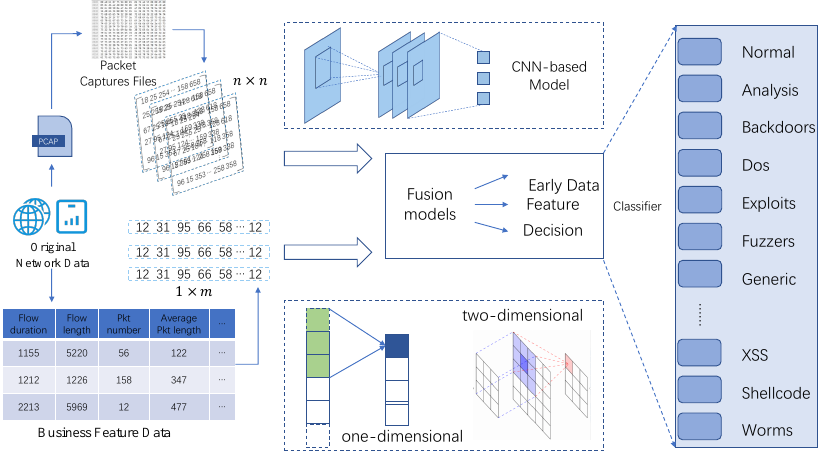
Figure 1. This figure depicts the process of malicious behavior detection. It contains two types of raw data collected from network traffic and three fusion methods. Detection results can be improved by using different fusion